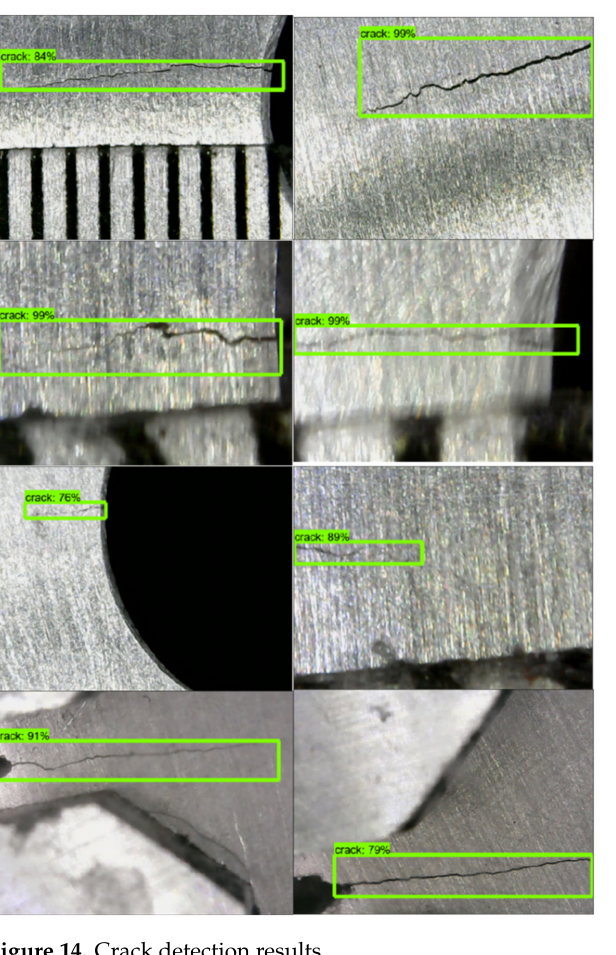
Figure 14. Crack detection results.